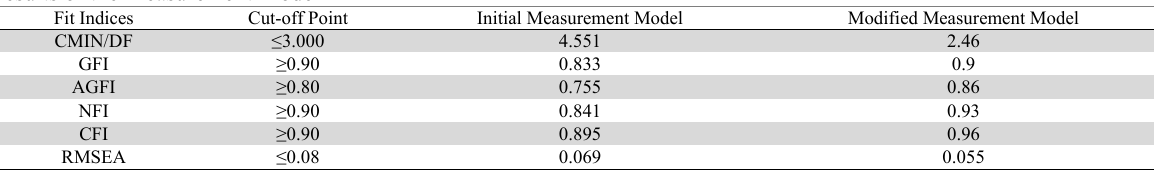
Results of the Measurement Model